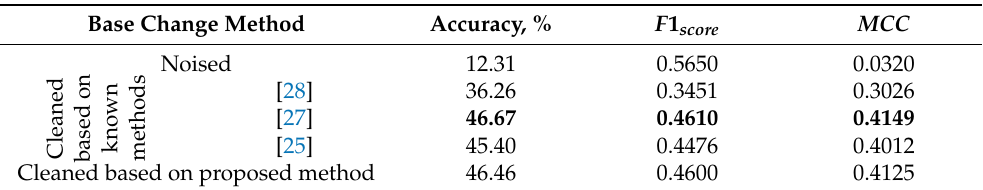
Table 4. Criteria and metrics of recognition accuracy of the CIFAR10 base, previously cleared of 1% random-valued impulse noise. Table 7. Criteria and metrics of recognition accuracy of the CIFAR10 base, previously cleared of 50% random-valued impulse